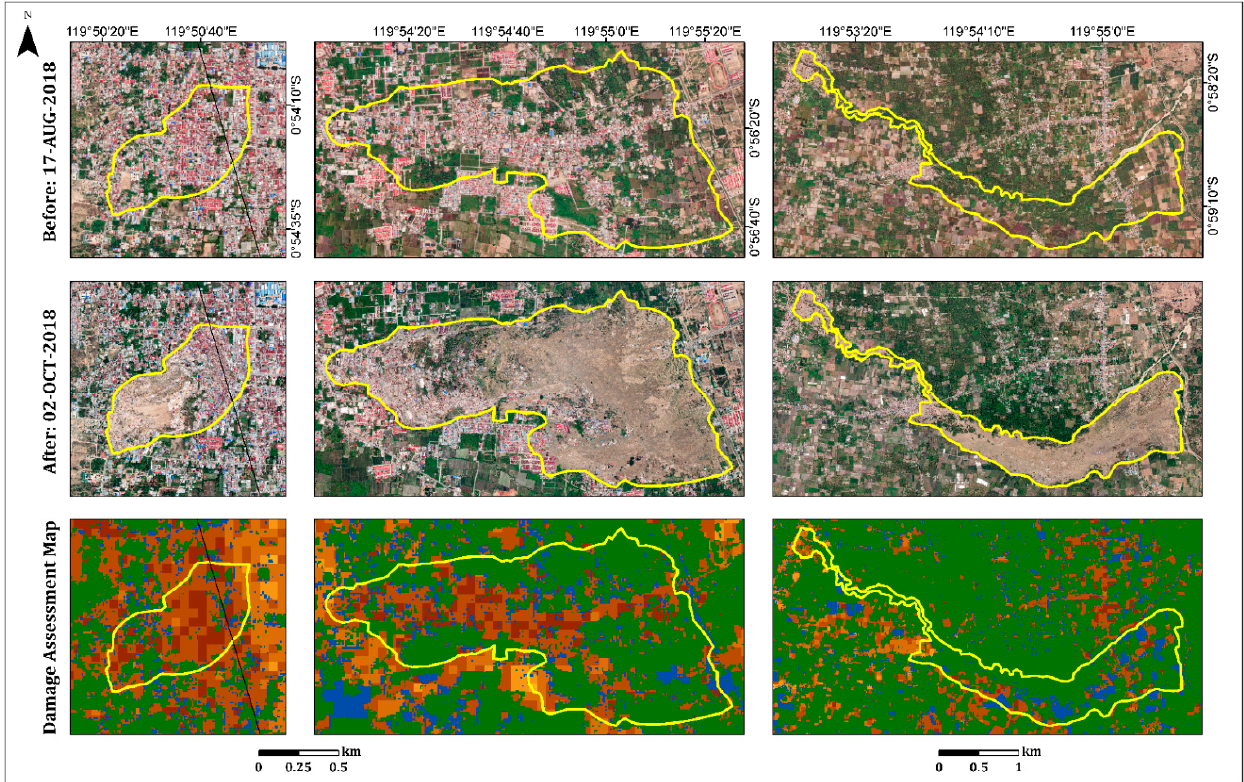
Figure 8. Insets showing the three villages ( left to right ): Balaroa, Petobo and Jono Oge. Pre-event optical image (17 August 2018), post-event optical image (2 October 2018), and the damage assessment map (see legend in Figure 5).